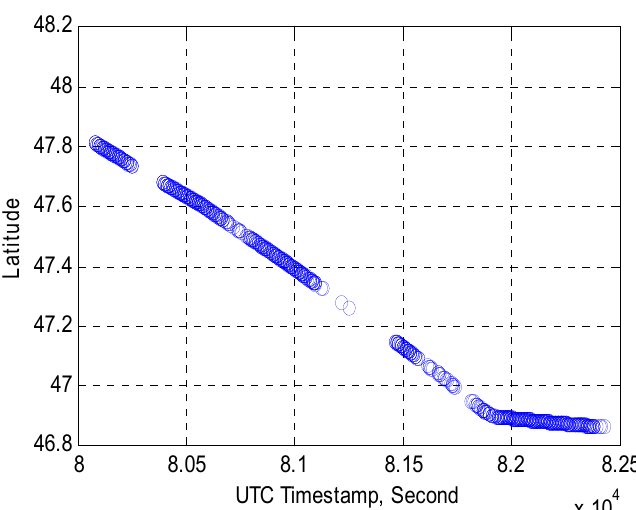
Figure 1. Multiple drop-outs in a flight. Latitude data is used to represent the data gap. In the x -axis, time is represented as the current time-of-day in whole seconds elapsed since coordinated universal time (UTC) midnight. In the 70 min flight span, data were missed several times. This flight is randomly chosen to visually represent drop-out. Adopted from [16].